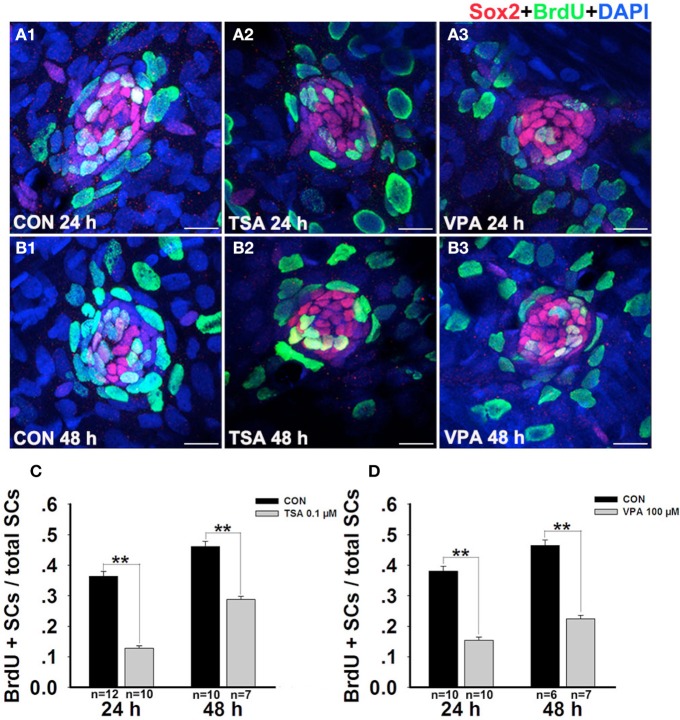
HDAC inhibitors significantly suppresses cell proliferation. (A and B) Lateral line SCs are stained with Sox2, and the BrdU antibody shows dividing cells in the neuromasts of zebrafish. (C and D) Quantification of the ratio of BrdU+ SCs in control and TSA- or VPA-treated larvae at 24 h and 48 h after neomycin incubation. Bars are mean ± s.e.m. and n = total number of embryos. **p < 0.001.